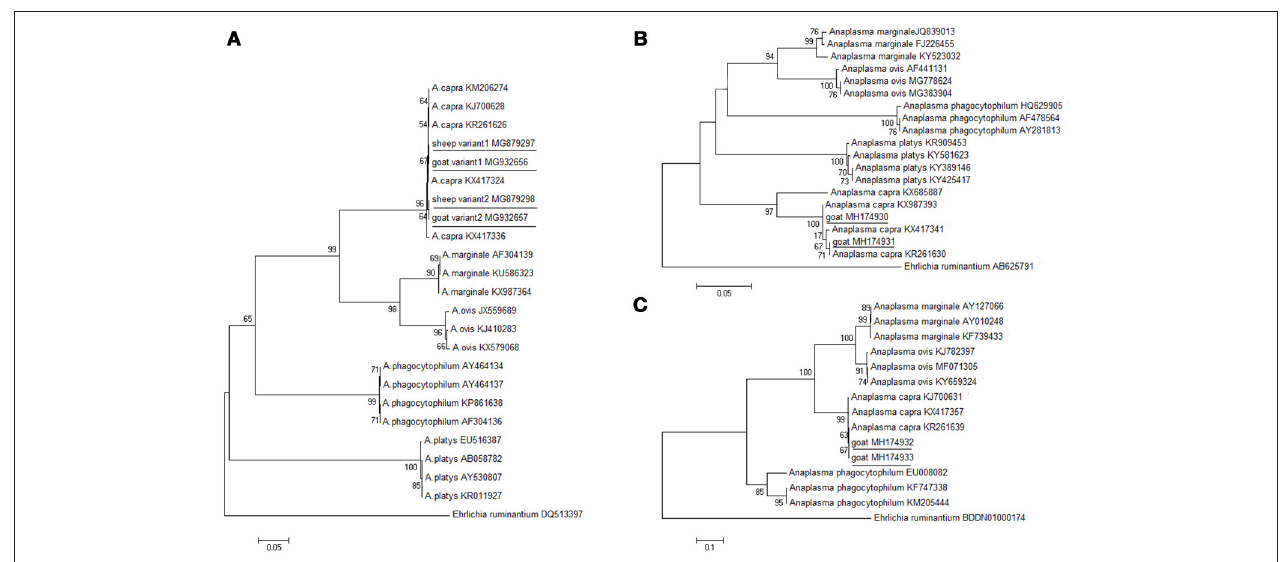
FIGURE 2 | Phylogenetic analysis of A. capra identified in this study based on the gltA (A) , groEL (B) , and msp4 (C) genes. The tree was constructed using the neighbor-joining method and the numbers on the tree indicate bootstrap values for the branch points. Numbers on the branches indicate percent support for each clade. Ehrlichia ruminantium was used as outgroup. The sequences from this study are underlined. The numbers of nucleotides were 594, 874, 656 bp in the final alignment of gltA , groEL, and msp4 , respectively.